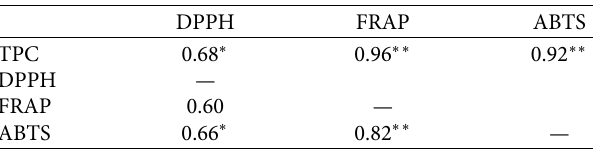
Table 4: Linear correlation coefficients among the different anti- oxidant